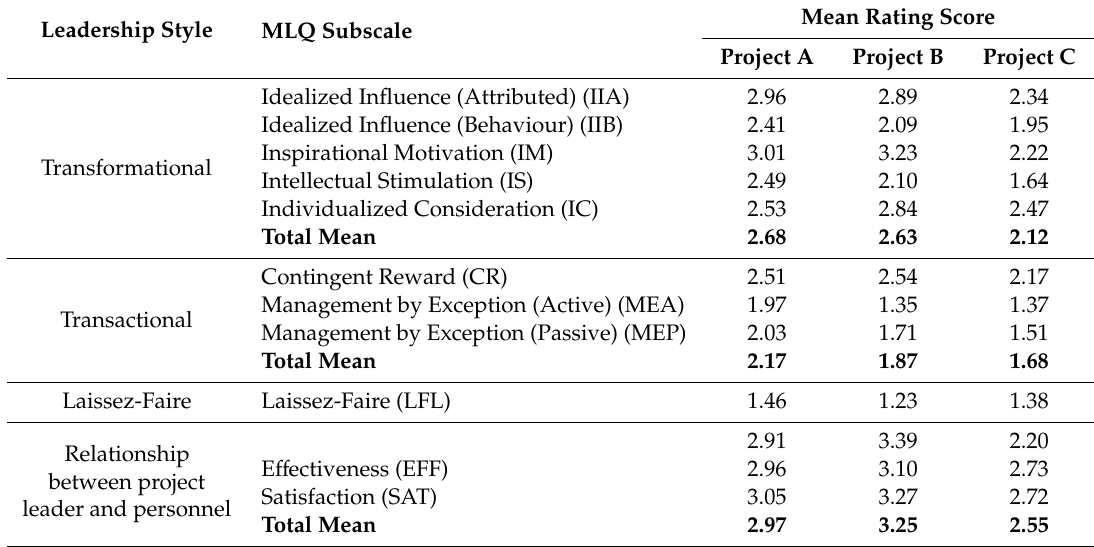
Table 3. Multifactor Leadership Questionnaire (MLQ) ratings on Leadership styles employed in the three